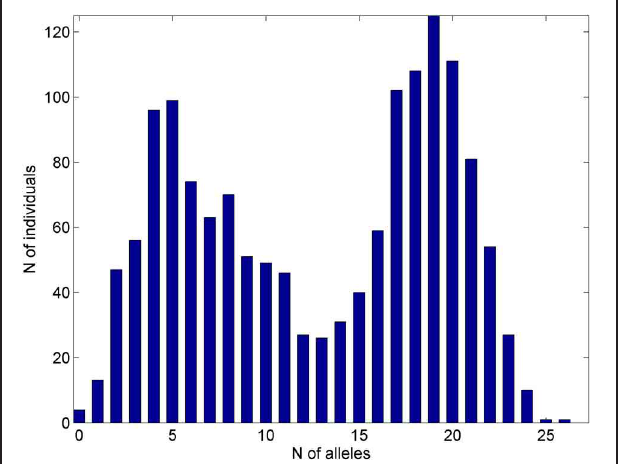
FIGURE 1 | Distribution of the numbers of pro-survival alleles out of 27 of such alleles selected in Yashin et al. (2012c) in the sample of genotyped individuals in the FHS Original